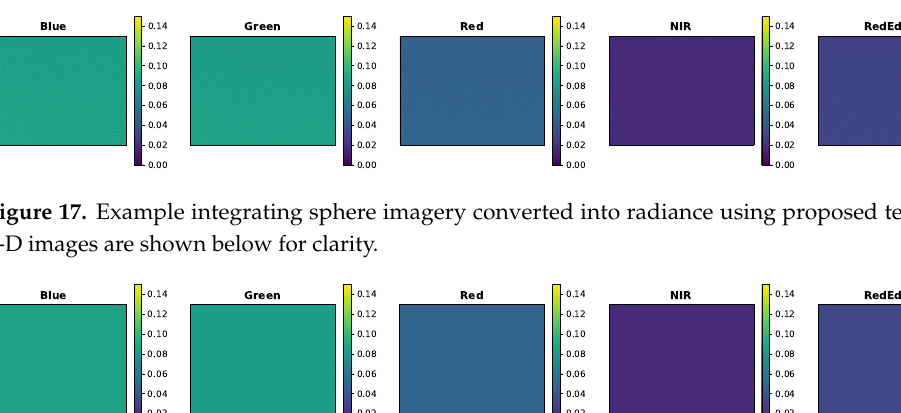
Figure 16. Example integrating sphere imagery converted into radiance using MicaSense radiance methodology. 3-D images are shown below for clarity.